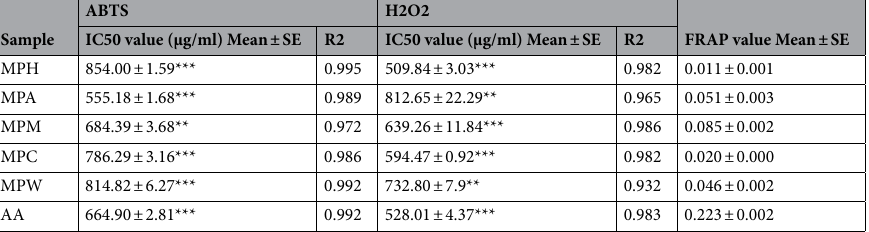
Table 2. Free radical scavenging ability of M. paniculata extracts from ABTS and H 2 O 2 scavenging assays, FRAP values represents as equivalent of Fe2 + /gram sample. Values represented as Mean ± SE (n = 3). P value ( *** ): very highly significant; (**): highly significant, (*): significant.